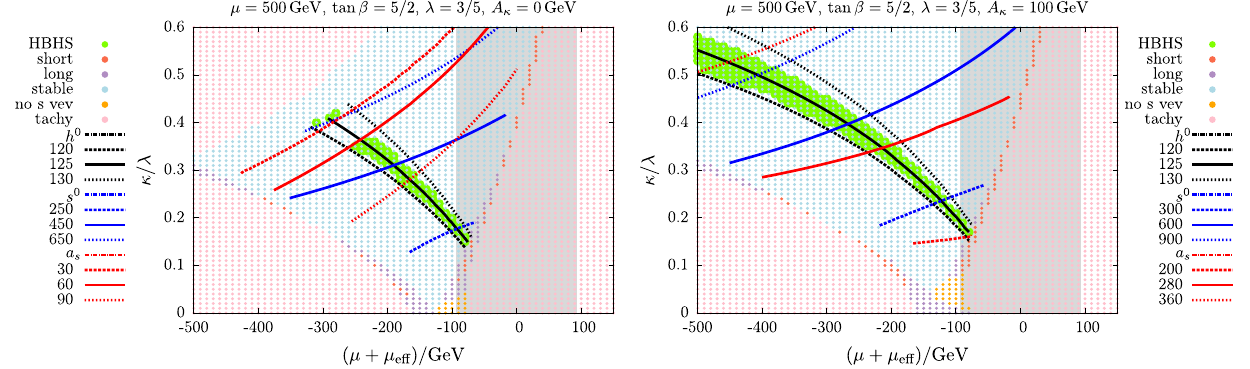
Fig. 4 Contours for the SM-like Higgs mass (black) and the masses of the two singlet-like states ( CP -even in blue and CP -odd in red) in the plane κ/λ versus (μ + μ eff ) , where λ = 0 . 6 and μ = 500GeV are kept fixedand κ and μ eff vary.Intheleftplot A κ = 0GeVisused;intheright one A κ = 100GeV. Furthermore, tan β = 2 . 5 is set in both plots. The other relevant parameters are listed in Table 1. The few red and purple points have a short- and long-lived meta-stable electroweak vacuum,